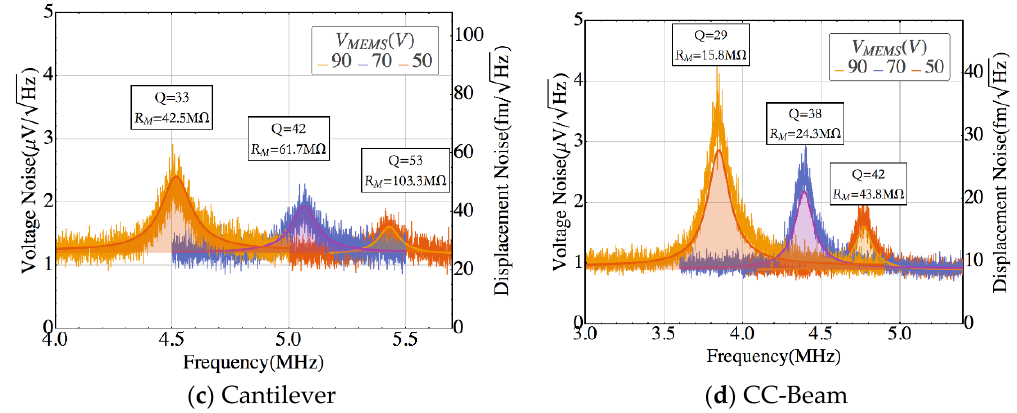
Figure 6. Measured voltage noise spectrum operated at ambient pressure and 20% relative humidity, compared to the theoretical model (solid-filled line) for various bias voltages at 20 °C. The values given for Q and 𝑅 𝑀 are derived from experimental data fitting. ( a ) Plate-B1, ( b ) Plate-B2, ( c ) Cantilever, and ( d ) CC-Beam.